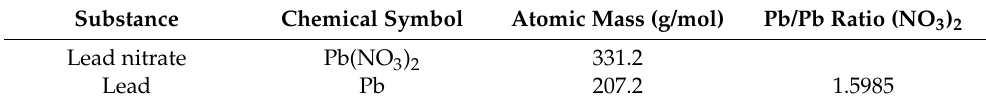
Table 2. Lead equivalence by lead nitrate.